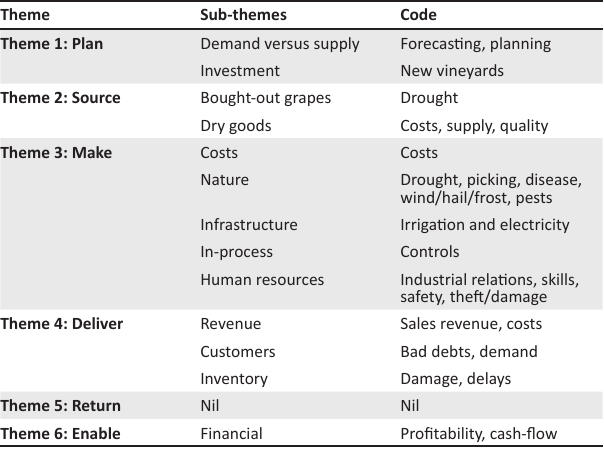
TABLE 5: Thematic analysis of the